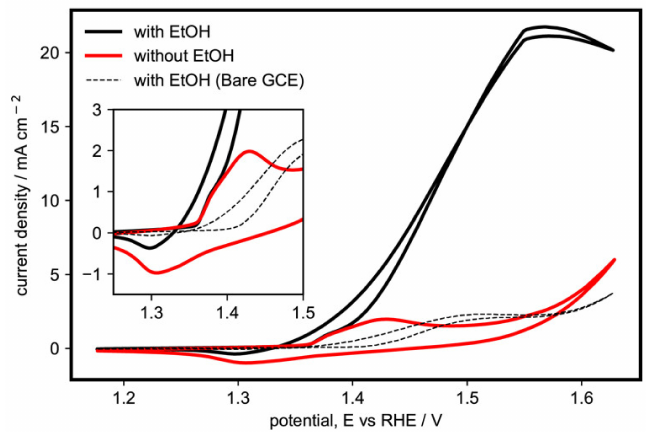
Figure 2. Cyclic voltammogram of α -Ni(OH) 2 microspheres with nanoflakes (sample G) in the presence and absence of 1 M ethanol in 1 M KOH (potassium hydroxide) at 20 mV s − 1 . Inset: Ni(OH) 2 / NiOOH redox